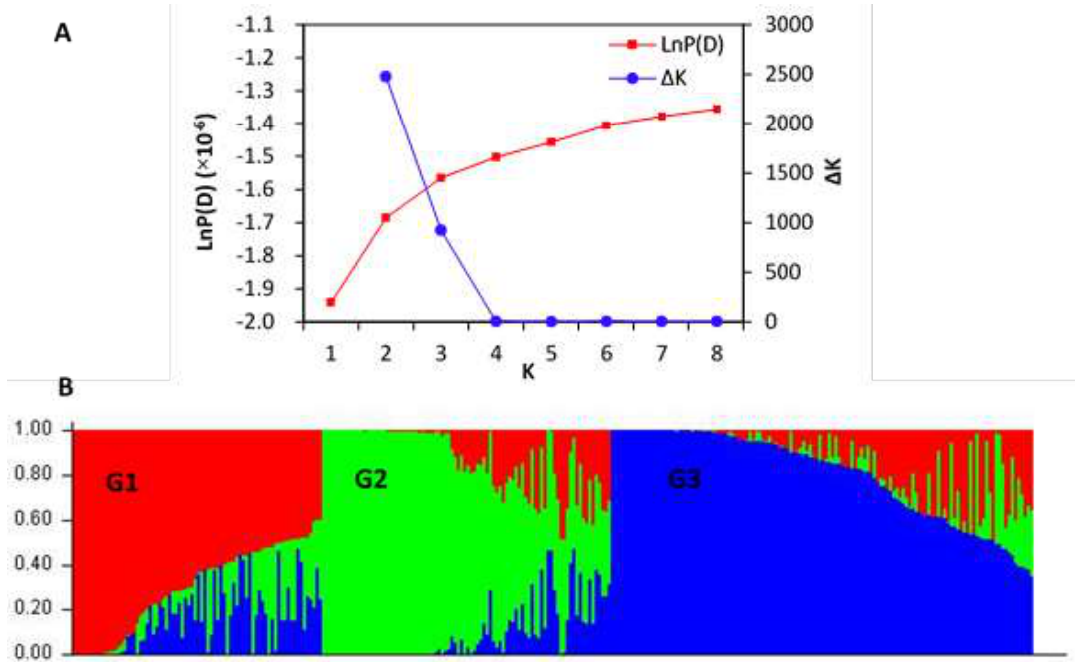
Figure 1. An estimated logarithm probability of the data likelihoods LnP(D) and magnitude of ∆ k for each K value in the population ( A ). LnP(D), the log probability of the data. K means subpopulations. ∆ k, delta K. Population structure results with three defined subpopulations (K = 3) ( B ). Numbers on X-axis represent germplasm and numbers on the y-axis indicate the membership coe ffi cient for each germplasm line. The three clusters: G1 = red, G2 = green, G3 = blue. Accessions with the same color belong to the same group. G1 mainly contains sweet sorghum and sudangrass; G2 consists of sweet sorghum, sudangrass, sudangrass inbred lines and sweet sorghum inbred lines, and G3 mainly includes sweet sorghum and grain sorghum. Table 3. Three population structure groups di ff ering in plant height (HT), tiller number (TN), internode number (IN), stem diameter (SD), panicle length (PL), panicle weight (PW), reducing sugar (RS), Brix, and protein (PRO) in the population across three